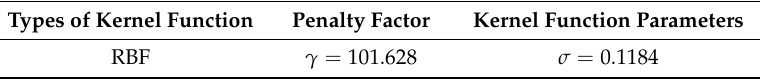
Table 3. Optimal kernel function parameters.